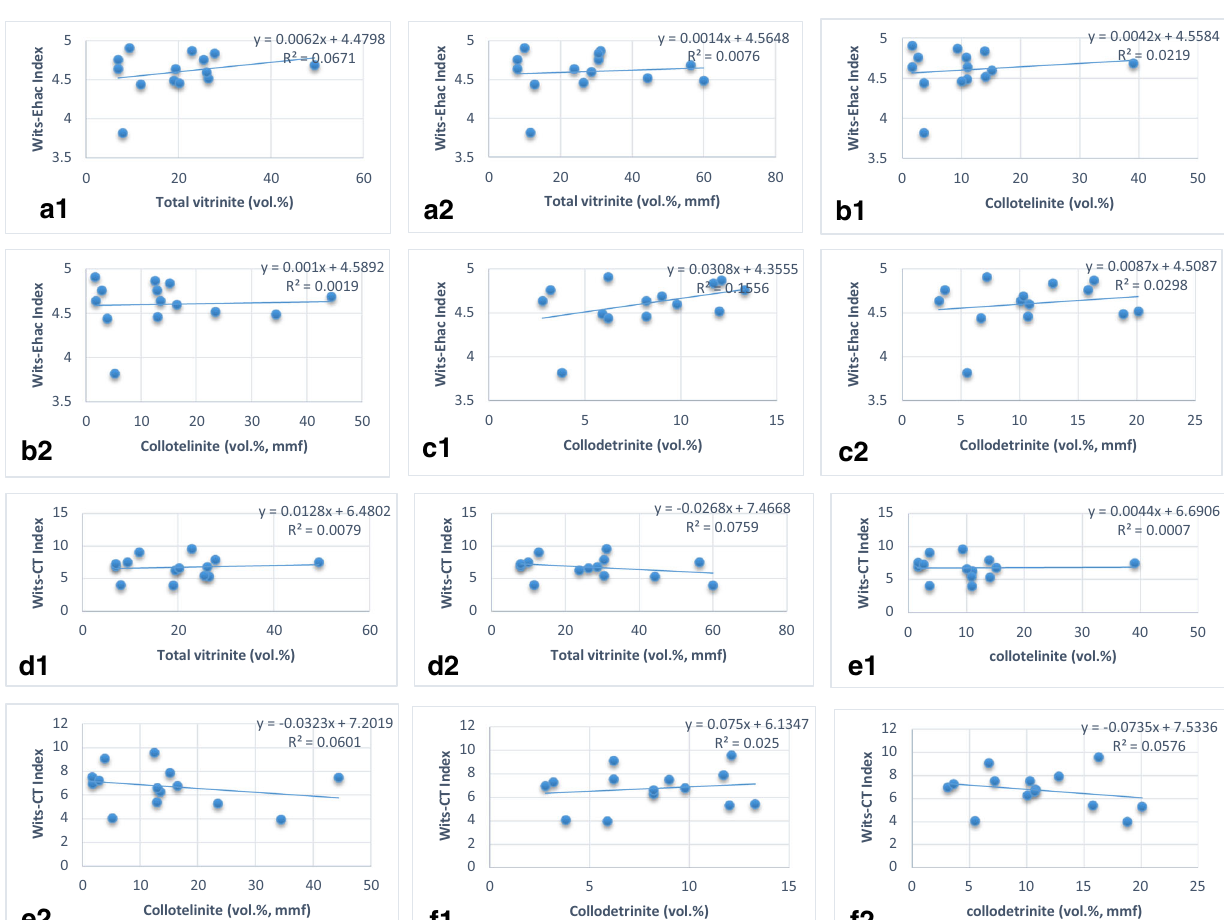
Fig. 7 Influence of vitrinite and its group on spontaneous combustion of